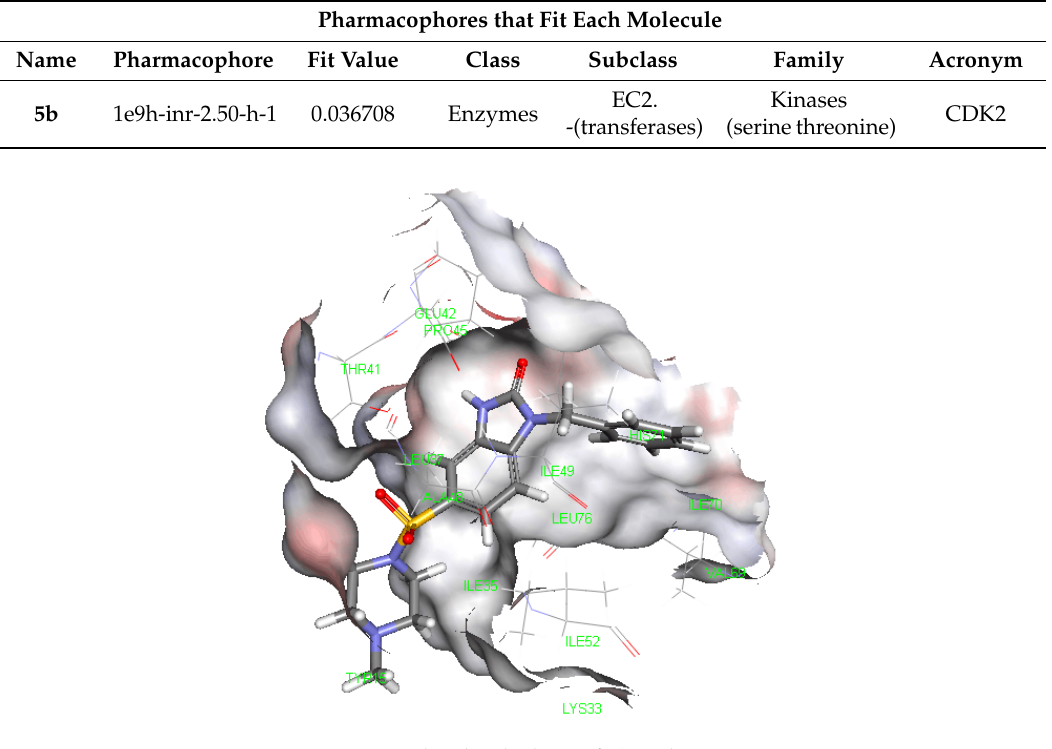
Figure 3. Molecular docking of 5b and CDK2.